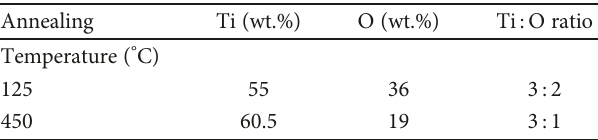
Table 2: E ff ect of the heat treatment post annealing for 40V, room temperature anodized sample.